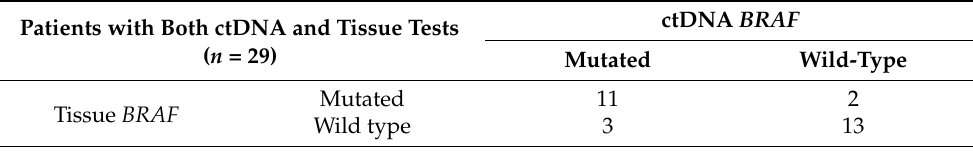
modality and concordance of results between ctDNA and tissue sample